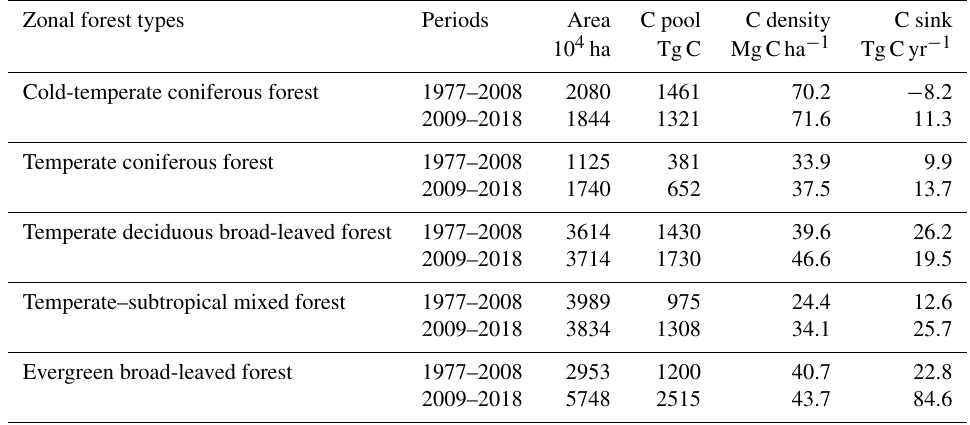
Table 3. Area, biomass C pool, C density, and average C sink of different zonal forest types in the most recent decade compared to the previous 30 years ∗